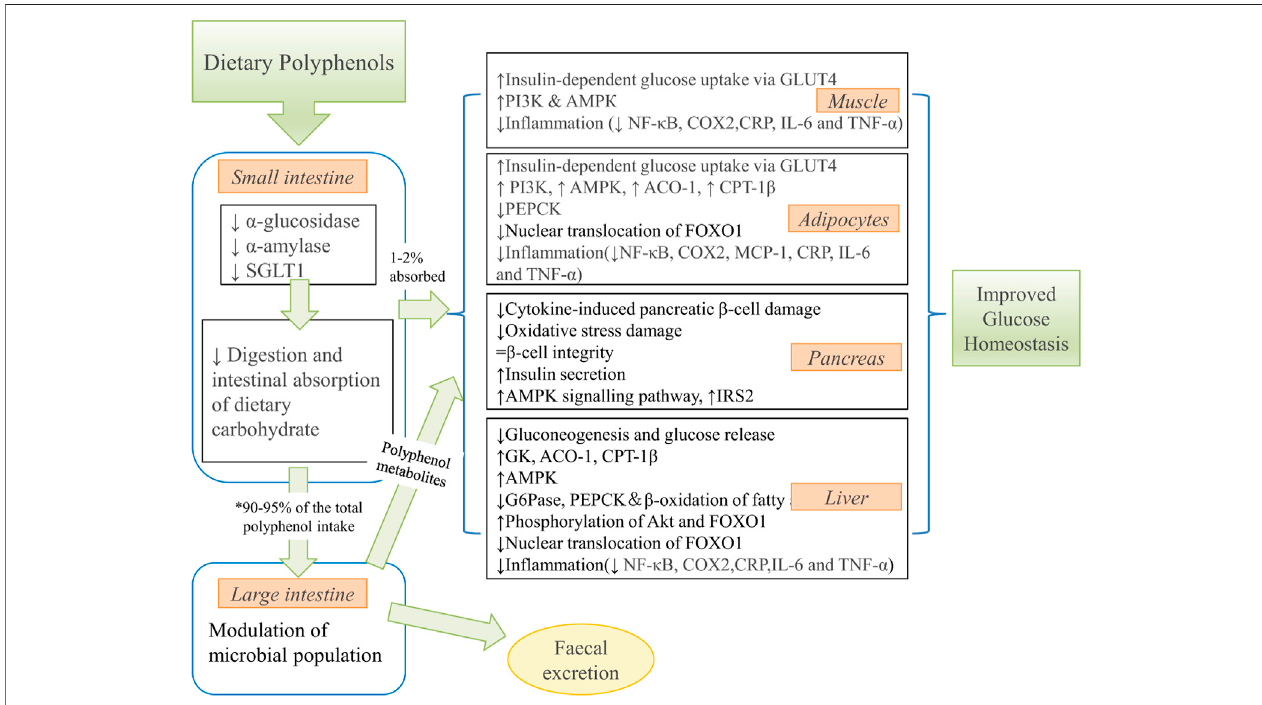
FIGURE8| Thesummaryofpotentialmechanismslinkingdietarypolyphenolmetabolitestoimprovedglucosehomeostasis. ↑ ,increase; ↓ ,decrease.*90 – 95%of the ingested polyphenols reach the colon. SGLT1, sodium-dependent glucose transporter; GLUT4, glucose transporter four; PI3K, phosphoinositide 3-kinase; AMPK, 5 ′ adenosine monophosphate-activated protein kinase; NF- κ B, nuclear factor kappaB; COX2, cyclooxygenase-2 protein; CRP, C-reactive protein; IL-6, interleukin 6; TNF α , tumor necrosis factor α ; ACO-1, acyl CoA oxidase-1; CPT-1 β , carnitine palmitoyl transferase-1 β ; PEPCK, phosphoenolpyruvate carboxykinase; FOXO1, forkhead box protein O1; MCP-1, monocyte chemoattractant protein-1; IRS2, insulin receptor substrate two; GK, glucokinase; G6Pase, glucose-6-phosphatase. (reproduced with copyright permission from MPDI (Kim et al.,